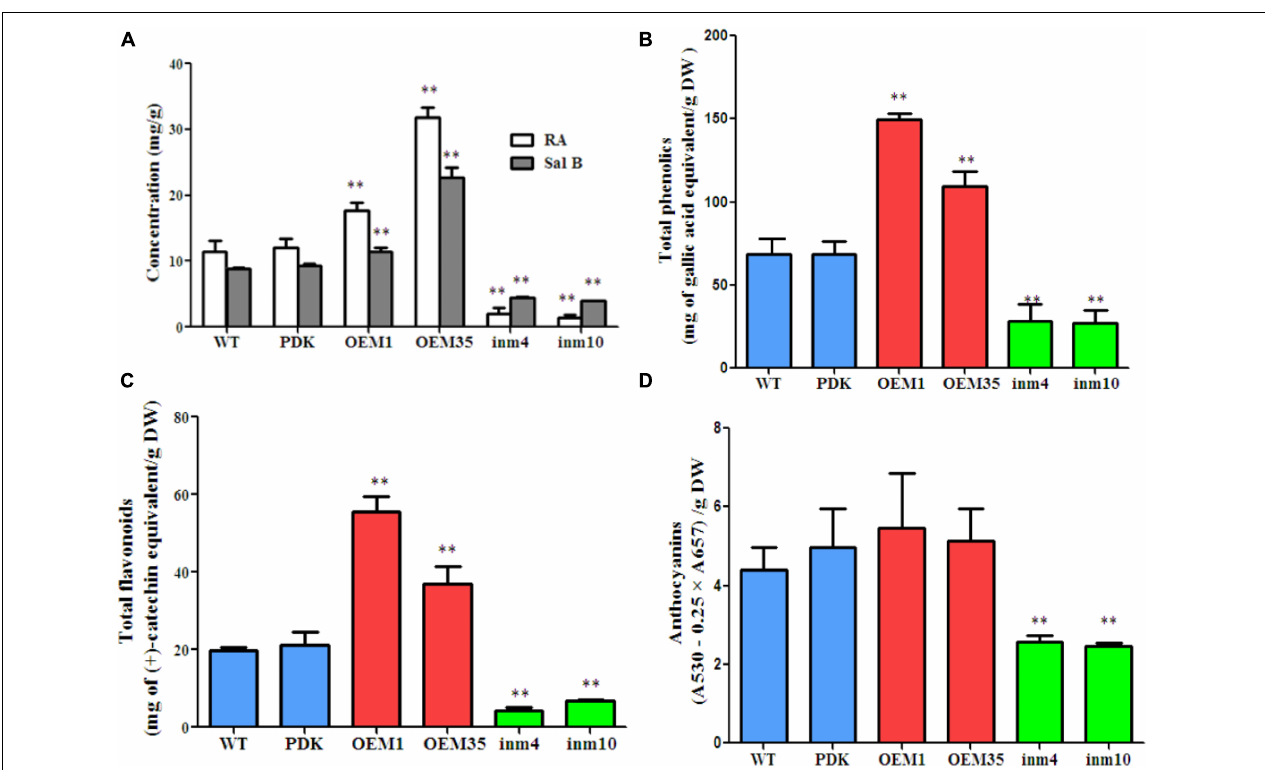
FIGURE 6 | Comparison of secondary metabolite concentrations between transgenic lines and controls. (A) Levels of RA and Sal B in root extracts. (B–D) Levels of total phenolics (B) , total flavonoids (C) , and anthocyanins (D) from root extracts. The data represent means ± SD of three independent experiments. ∗∗ p < 0.01 compared with the wild type (Student’s t